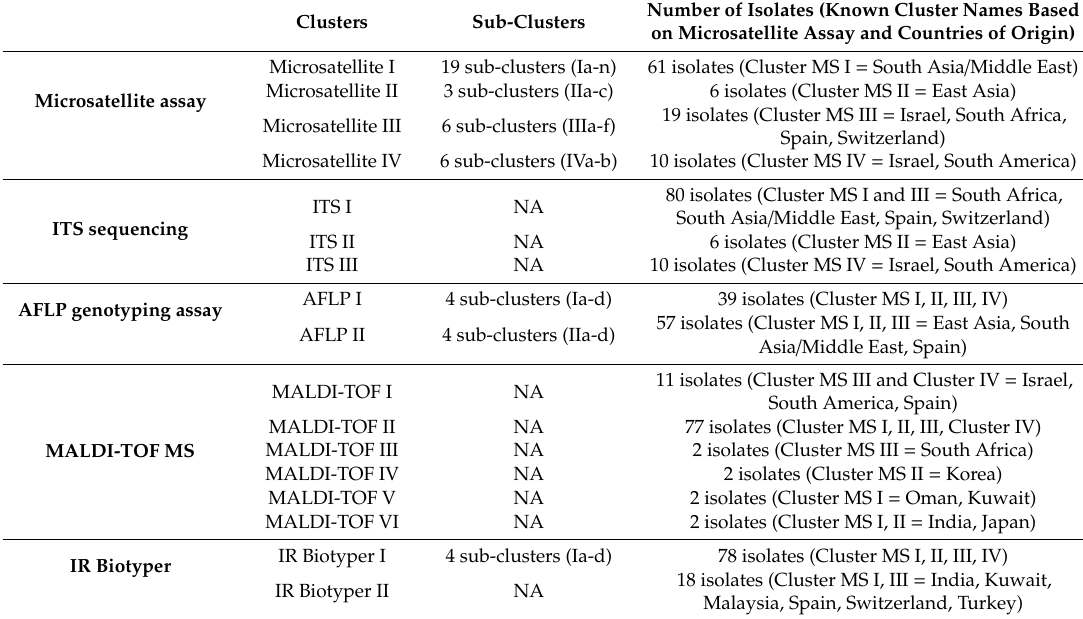
Table 1. A summary of the clusters and sub-clusters created by the five typing methods used in this study.